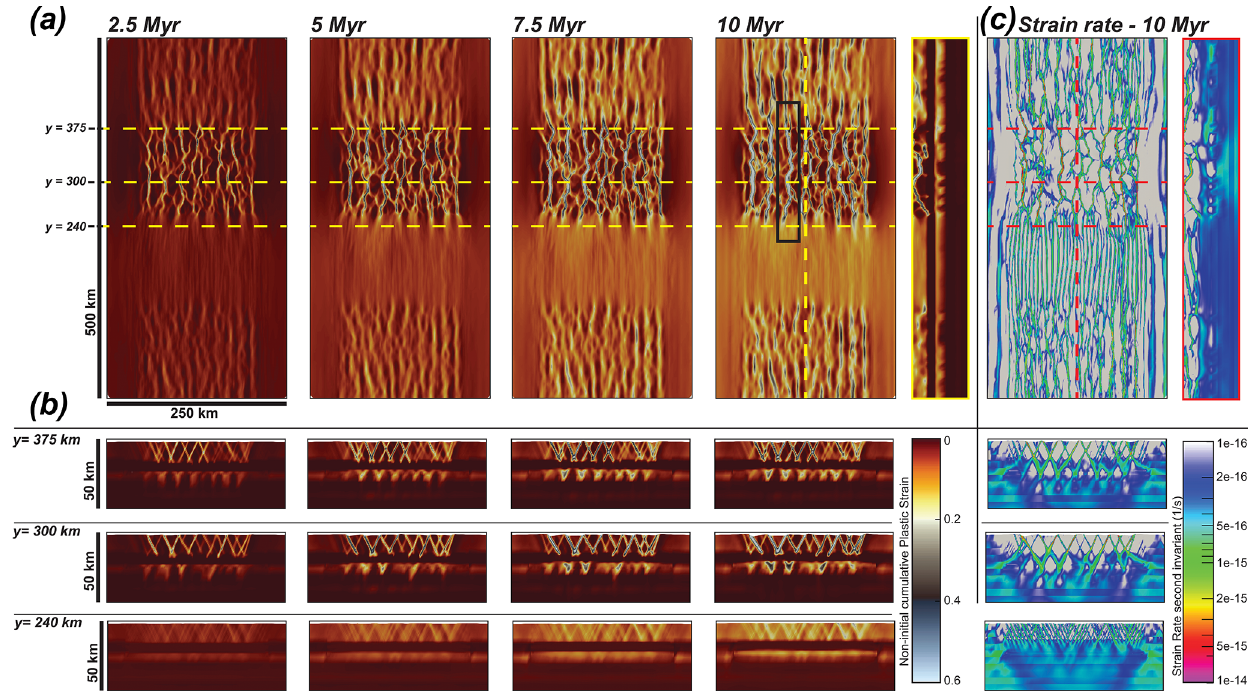
Figure 4. (a) Map view images highlighting the fault evolution across the model using the non-initial plastic strain attribute at 2.5, 5, 7.5, and 10Myr. The black box shown for the 10Myr model time step shows the location of Fig. 6. (b) Cross-sectional views across the centre of the weak domain ( y = 300km), the boundary between the north reference and weak domains ( y = 375km), and within the strong domain 10km from the weak domain boundary ( y = 240km). Cross sections shown at 2.5 × vertical exaggeration. (c) Map and cross-sectional views of the strain rate attribute highlighting the fault network at